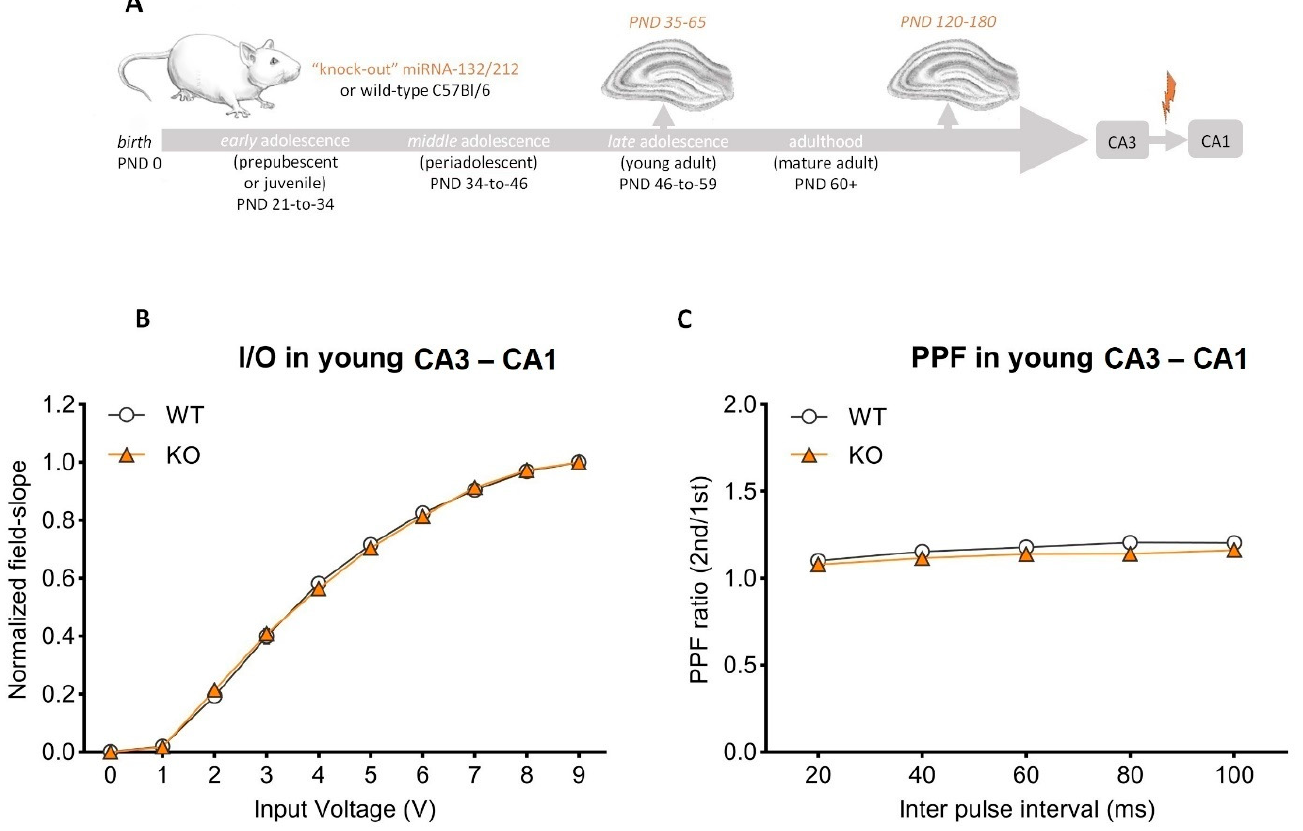
Figure 2. Unaltered basal synaptic transmission and paired-pulse facilitation in adolescent or adult hippocampal CA3–CA1 synapses of miRNA-132/212 knockout mice. ( A ) Schematic study design and experimental approach to study LTP induction at the Schaffer collateral output synapses. ( B ) Averaged field slopes vs. stimulation voltages (as derived from I/O protocols) for adolescent (PND 35–65) wild-type (WT; n = 16) and miRNA-132/212 − / − mice (KO, n = 12). Data showed no genotype differences (ns = p < 0.05; ANOVA (repeated measures) was followed by the Bonferroni test; error bars presented as SEM). ( C ) Averaged PPF ratios vs. increasing inter-pulse intervals. No differences are apparent between groups (ns = p < 0.05; ANOVA (repeated measures) followed by the Bonfer- roni test; error bars presented as SEM). ( D ) Averaged field slopes vs. increasing stimulation voltages (from I/O protocols) in mature-adult (PND 120–180) wild-type (WT, n = 11) and miRNA-132/212 − / − (KO, n = 9) slices. No statistical differences between genotypes were apparent (ns = p < 0.05; ANOVA (repeated measures) followed by the Bonferroni test; error bars presented as SEM). ( E ) Averaged